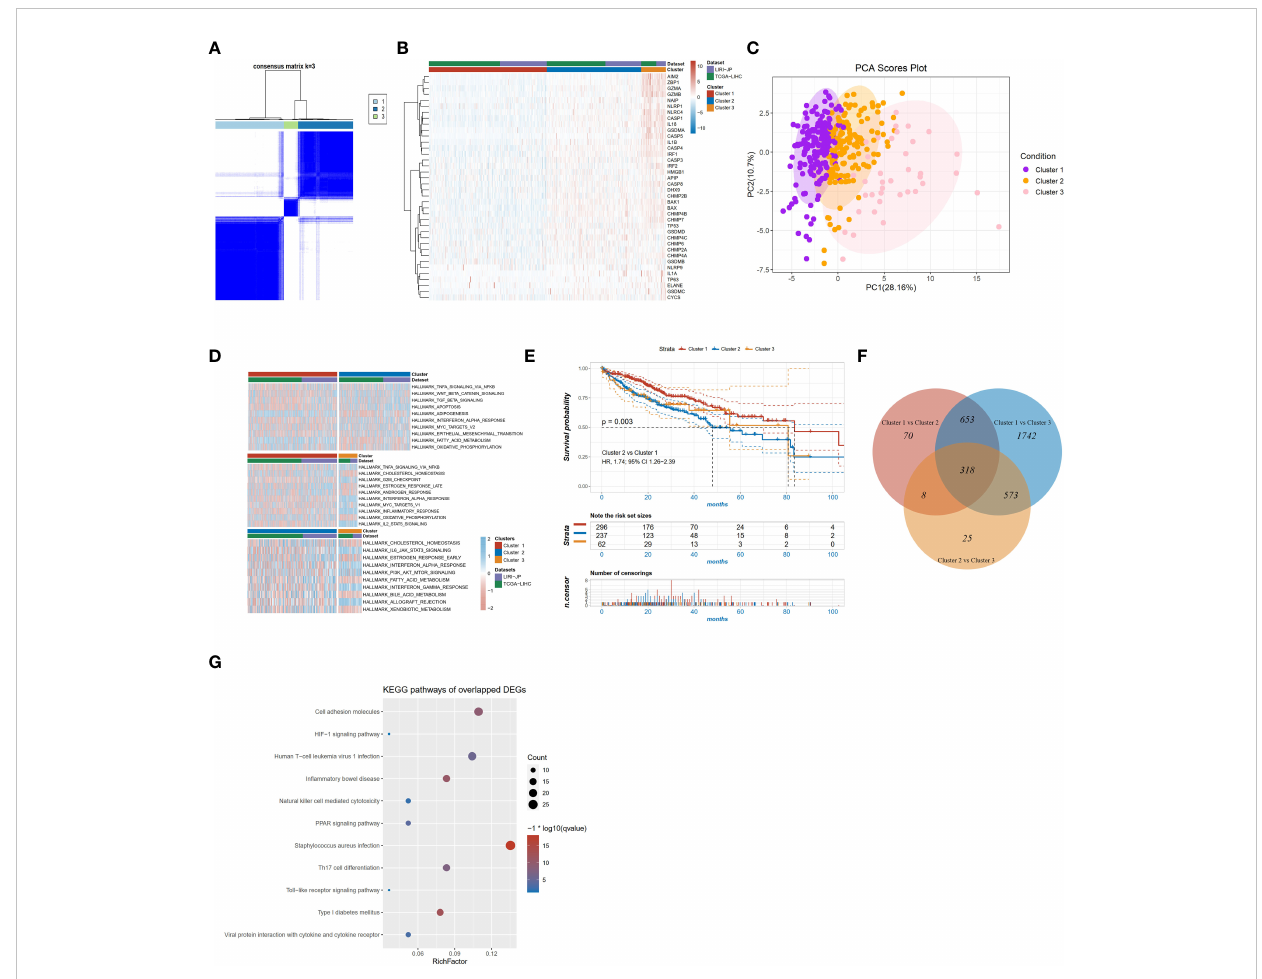
FIGURE 2 PRG clusters and biological characteristics of two distinct subtypes of samples divided by consistent clustering. (A) Consensus matrix heatmap de fi ning three clusters (k=3) and their correlation area; (B) Heatmap of the mRNA expression of PRGs in the three clusters; (C) Principal components analysis of the three clusters; (D) GSVA of cancer hallmarks between three distinct clusters; (E) KM survival curve of the three clusters; (F) Venn diagram showing overlapping genes of the signi fi cant expressed genes between the three pyroptotic clusters; (G) KEGG enrichment analyses of DEGs among the three pyroptosis